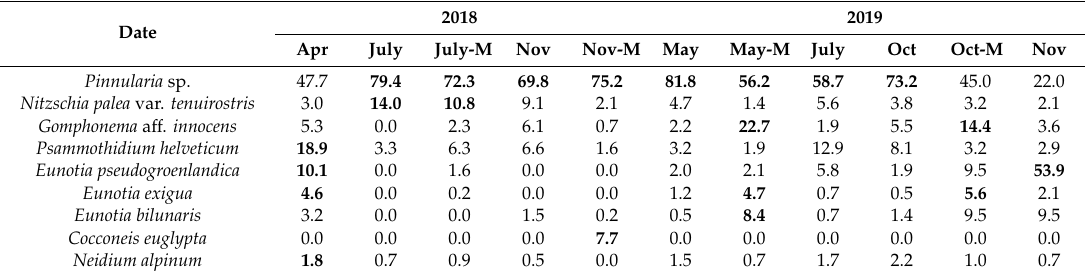
Table 4. Distribution of the dominant species in 2018 and 2019 (relative abundance > 1%) (M = macrophytes) (in bold: the highest percentages observed each